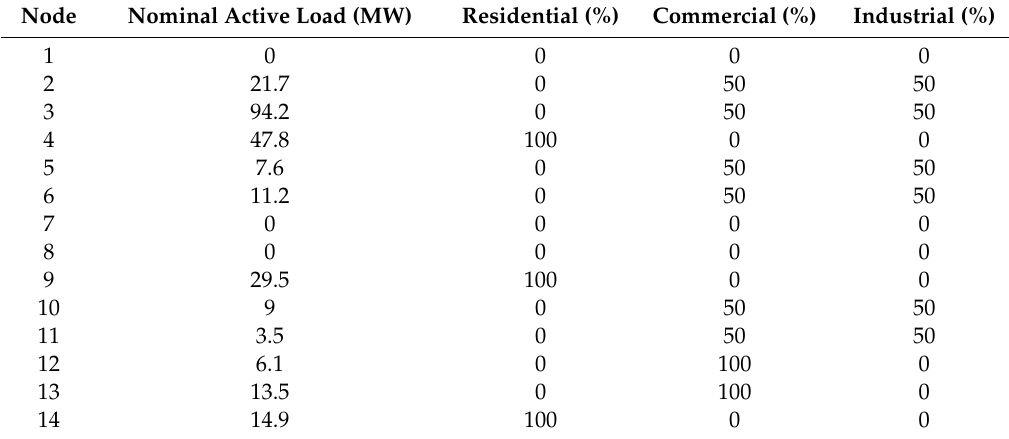
Table 1. Load profile proportion for each